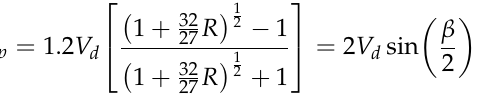
Table 2. Chemical composition of T2 red copper and HNASS (wt %).